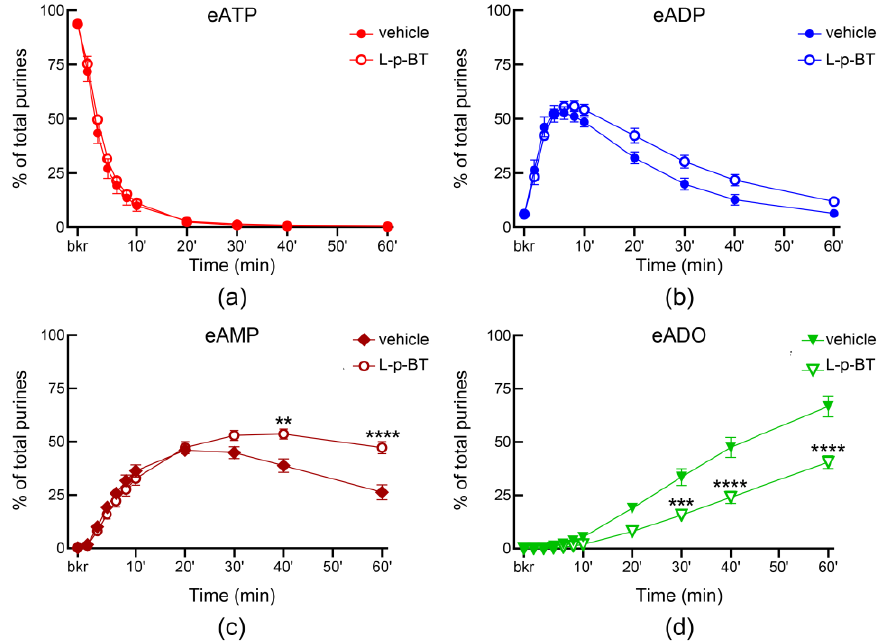
Figure 4. Effect of L- p -BT on the hydrolysis of eATP by soluble enzymes released in bladder lumen during filling. Changes in eATP ( a ), eADP ( b ), eAMP ( c ), and eADO ( d ) in ILS in the presence of vehicle (DMSO 0.1%, n = 7) or L- p -BT (100 µ M, n = 3); n , number of bladder preparations. eATP, eADP, eAMP and eADO are presented as percentages of total purines (eATP + eADP + eAMP + eADO) present in reaction solutions. Asterisks denote significant difference from vehicle controls.